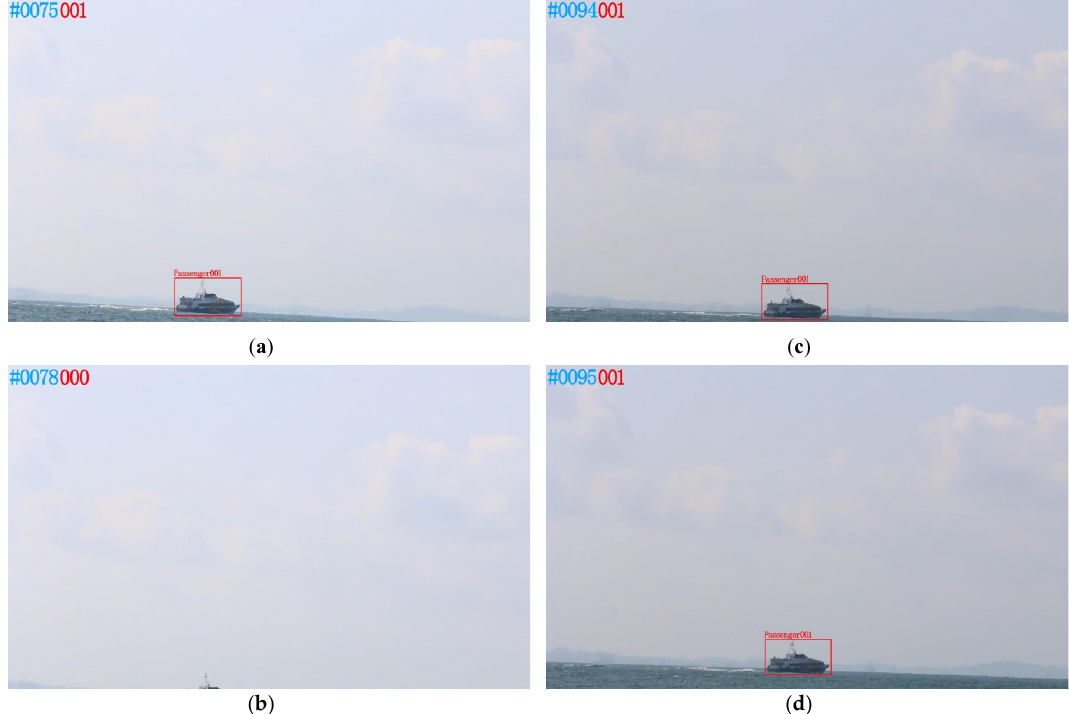
Figure 7. Visual tracking results of video sequence (MVI_0799_VIS_OB) with reappear after lost. In frame #0075 (a), a vessel has been stably tracked. Due to the rolling of the ego vessel, Passenger001 gradually disappeared from the camera scene in frame #0076 until frame #0078 (b), when it completely disappeared. Subsequently, it began to reappear in frame #0091 until frame #0094 (c), when it was completely visible. As shown in frame #0095 (d), the vessel was re-tracked steadily.